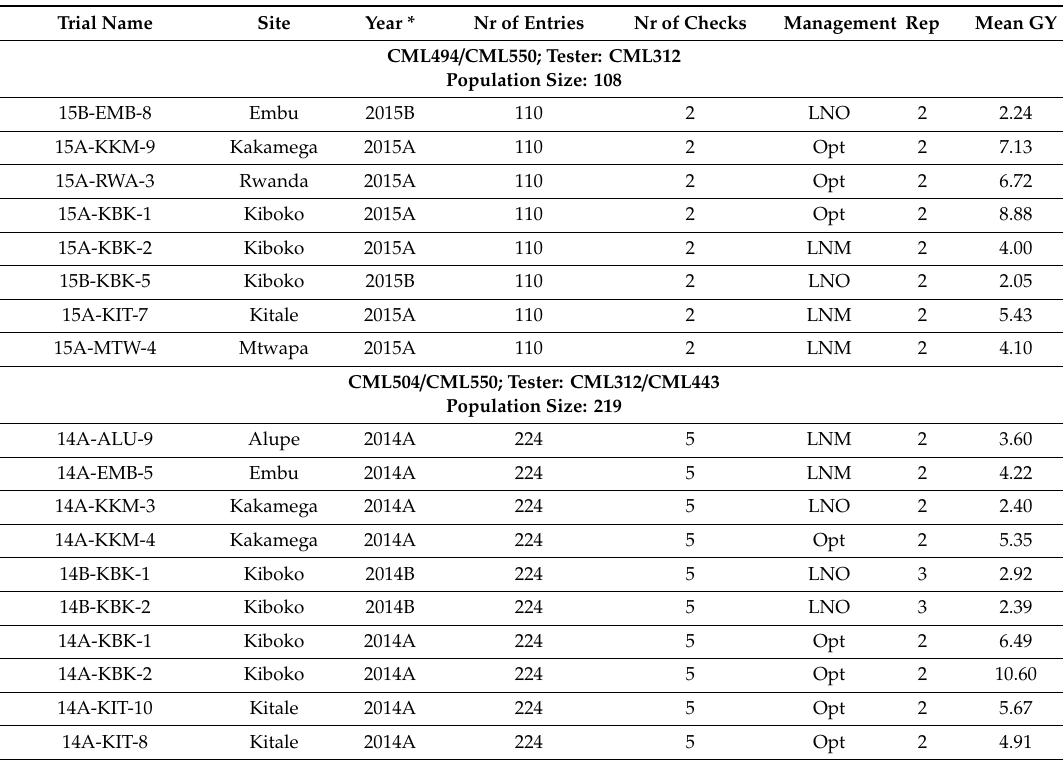
Table 5. Trial management information for testcross progenies of five double haploid bi-parental populations evaluated under optimum and low-N conditions in Kenya and Rwanda, from seasons 2014A to